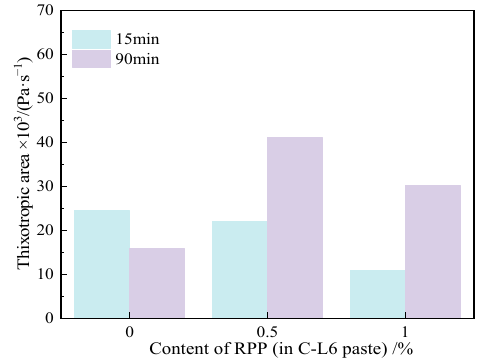
Figure 15. Thixotropic area of C-L6-RPP pastes.